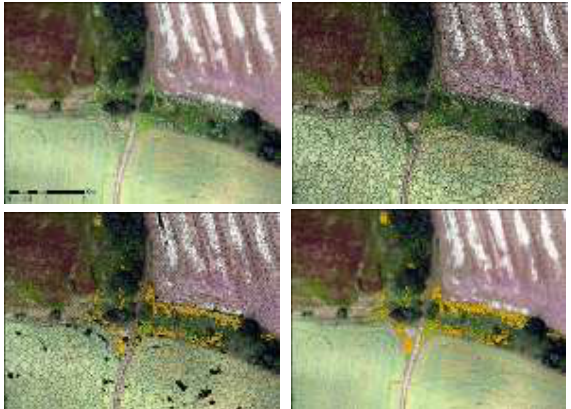
Figure 8. Detection of giant hogweed from UAV imagery using object oriented approach (resulting g. hogweed class is marked in orange) In case the objects are smaller than the pixel size, object- oriented approach would not bring much advantage over pixel- based one. In this case, species can be successfully detected if forming homogeneous stands (and ideally holding unique spectral characteristics). Most species are distinct only at certain phenological stage (typically flowering), and temporal data can be best acquired by UAVs (Figure 9). Such source typically provides imagery of lower spectral resolution; however additional temporal layers can increase the detection accuracy. If only one survey can be obtained, right timing based on phenology of the species is critical.